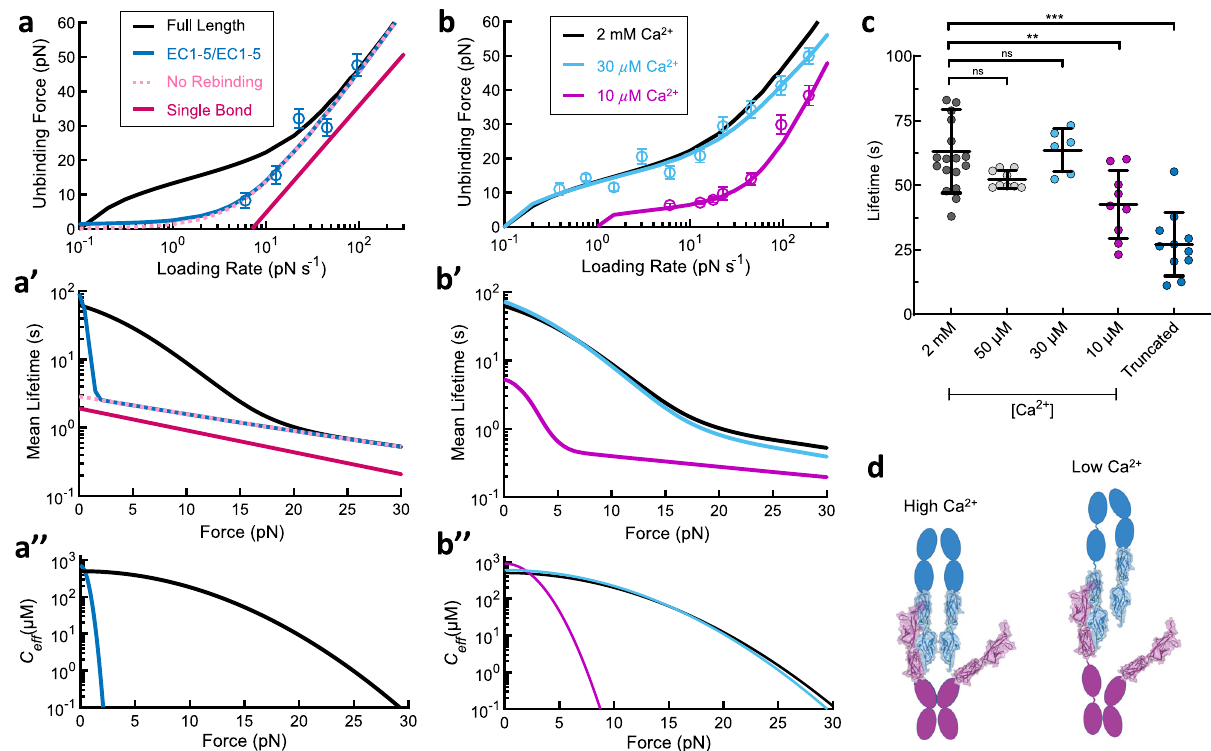
Fig. 4 Cis -dimerization and extracellular Ca 2 + alter the lifetime of the tip-link connection through elastic modulation. a Avidity under force is enhanced by cis -dimerization. Dimeric tip-link proteins were truncated to just the fi rst fi ve EC domains, to remove cis -dimerization interfaces further from the N termini. Unbinding forces (blue circles, n = 159 unbinding events) were fi t with the force-dependent avidity model, with fi xed parameters k off = 0.5 s − 1 and f β = 13.5 pN (EC1-5/1-5). Error is shown as the optimal bandwidth from a kernel density estimation. At the rupture forces tested, the model fi t was indistinguishable from a model in which there is no rebinding. a ’ Truncated proteins show an enhancement in lifetime above 6 pN primarily attributable to force-sharing. a ” C eff calculated from the fi t decreased rapidly with the applied force for EC1-5 dimers. b Low [Ca 2 + ] destabilizes the tip link. Unbinding forces in 30 µ M Ca 2 + (blue, n = 339 unbinding events) were nearly identical to those in 2 mM Ca 2 + (black), but were much lower in 10 µ M Ca 2 + (magenta, n = 344 unbinding events). Error is shown as the optimal bandwidth from a kernel density estimation. Model fi ts suggested that 10 µ M Ca 2 + weakened the connection both by accelerating the single-bond off-rate ( k off = 2.6 ± 0.8 s − 1 ) and by altering the mechanical properties of the protein complex ( f c = 2.9 ± 1.1 pN). b ’ Calculated lifetimes of the tip link in 30 µ M Ca 2 + at forces between 0 and 30 pN were indistinguishable from lifetimes